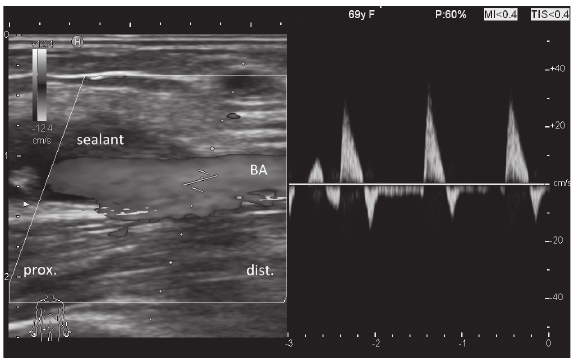
Figure 3: Ultrasound study of the left brachial artery the day after the first procedure (BA, brachial artery).